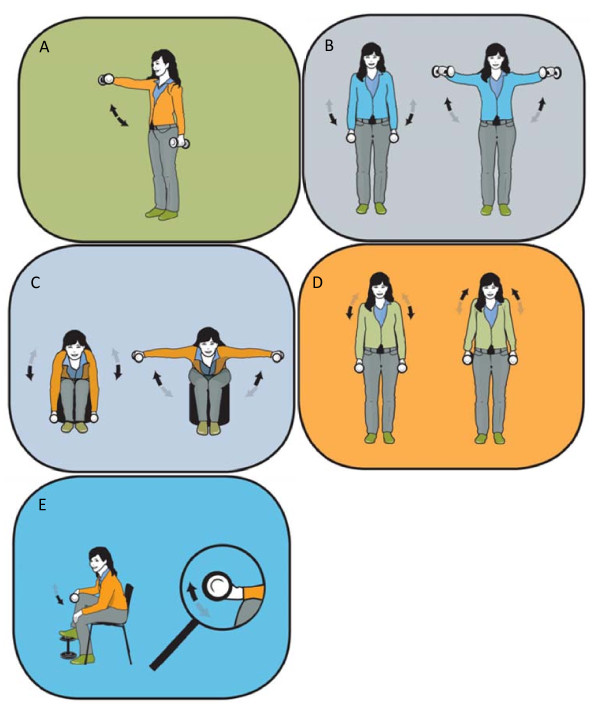
The five training exercises used in the present study. A) Front raise, B) lateral raise, C) reverse flies, D) shrugs, and E) wrist extension.